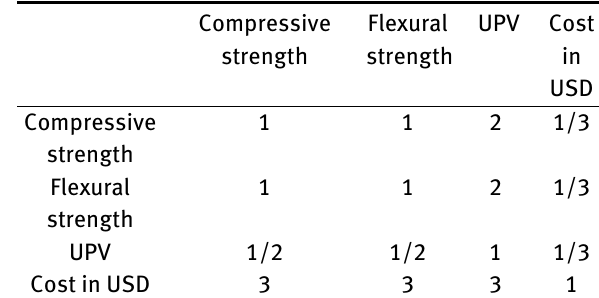
Table 13: The pair-wise comparison matrix (F) of reinforced green mortars (AHP method).